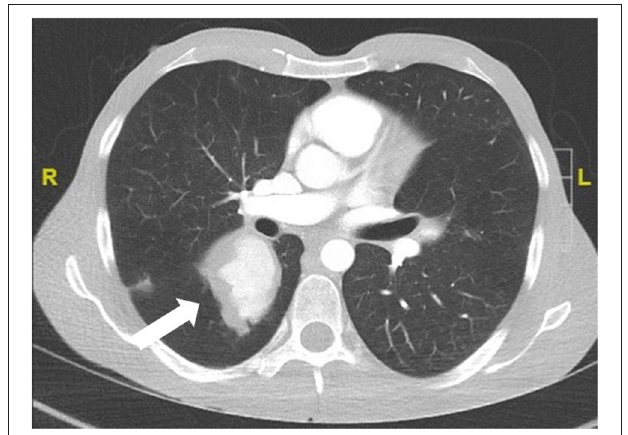
course, and the relapses may occur anywhere, although they tend to occur more often in the same segment or in close proximity to it (4, 22).